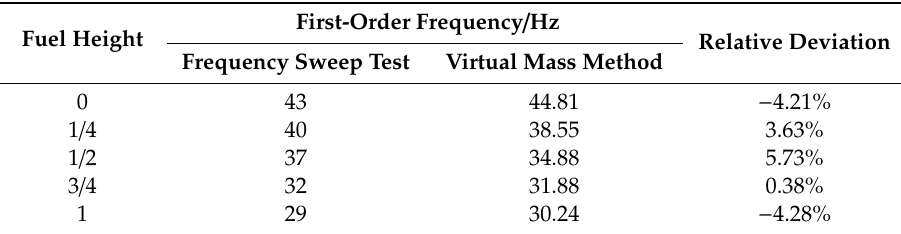
Table 2. Small-scale model test results and modal simulation results.